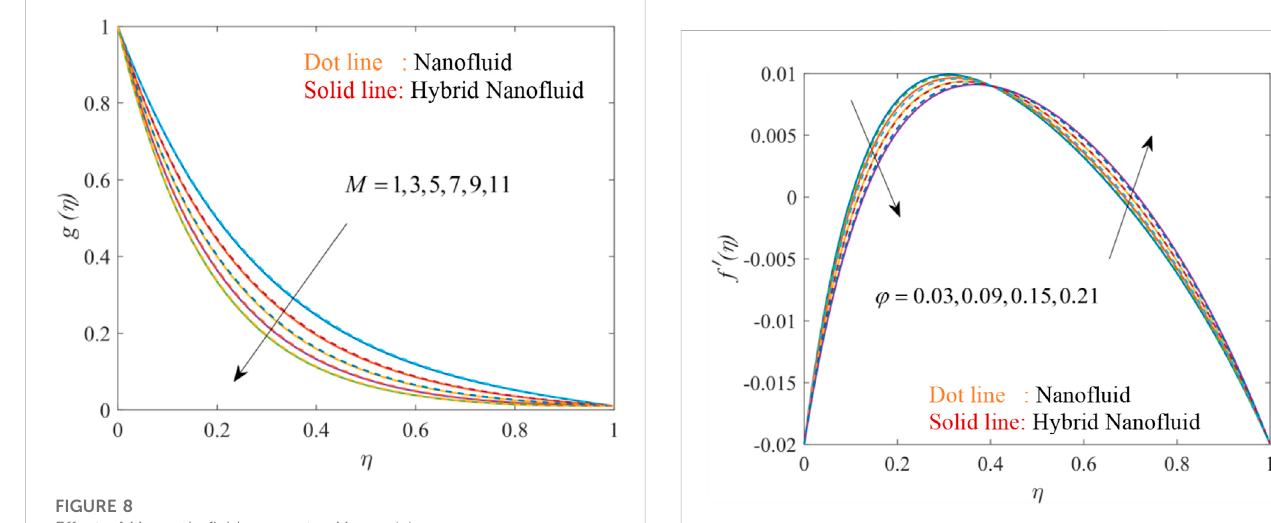
FIGURE 8 Effect of Magnetic fi eld parameter M on g ( η ) .